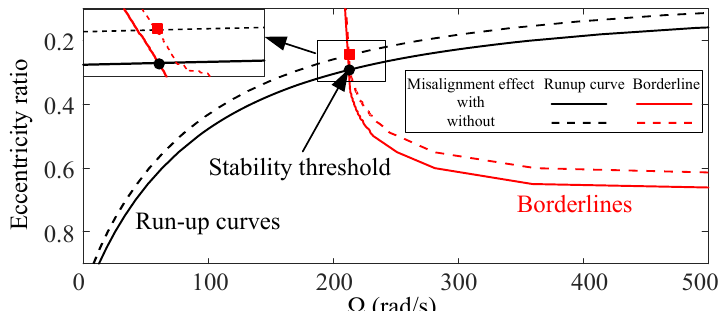
Figure 6. The influence of the misalignment effect on run-up curve and borderline.